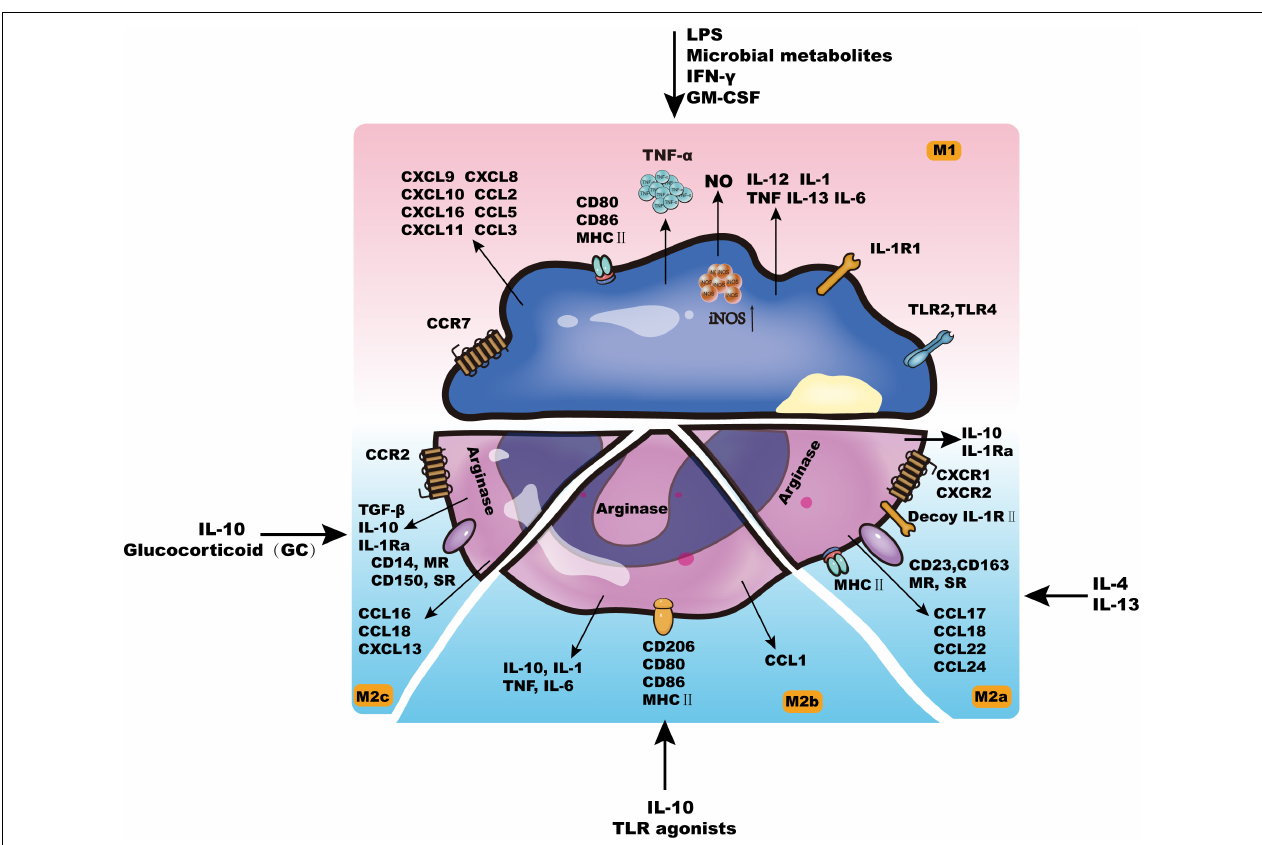
FIGURE 1 | The characteristics of